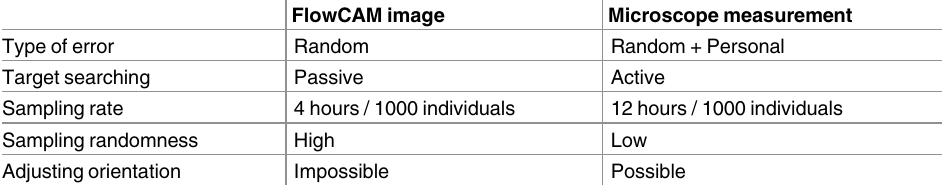
S1 Table. Biovolume data estimated with Area-Based-Diameter (V image measurements for the 7 dominant copepod morphotypes.